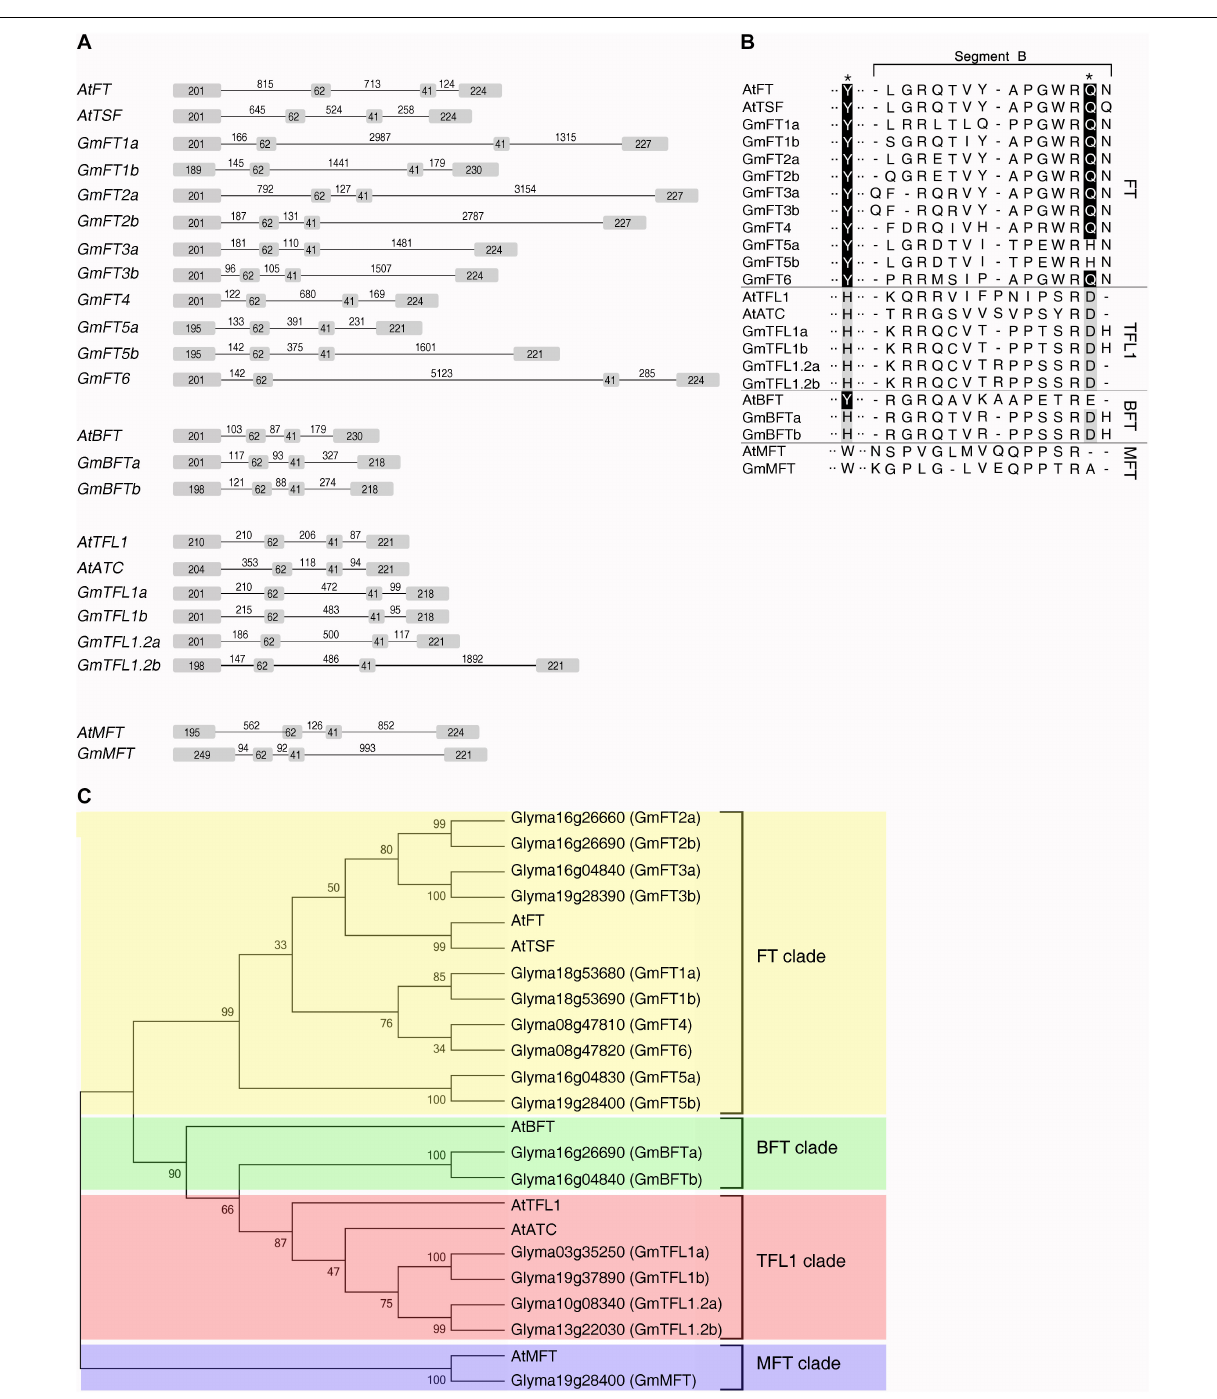
Frontiers in Plant Science |